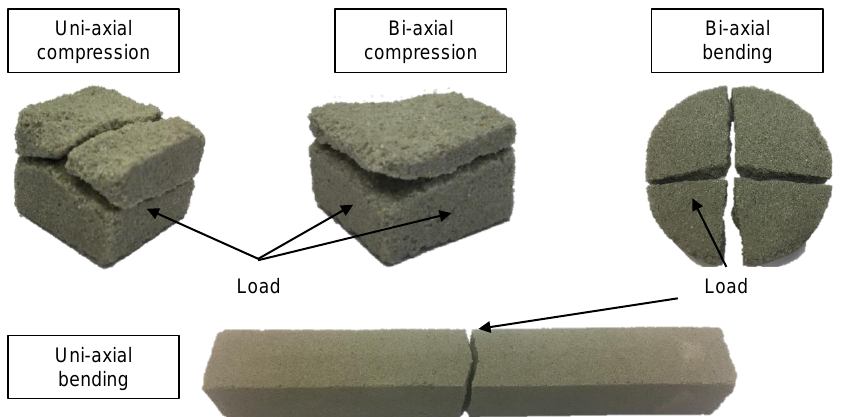
Figure 11. Typical examples of fractured specimens for the performed experiments. The compression and uni-axial experiments show signs of a shear failure.